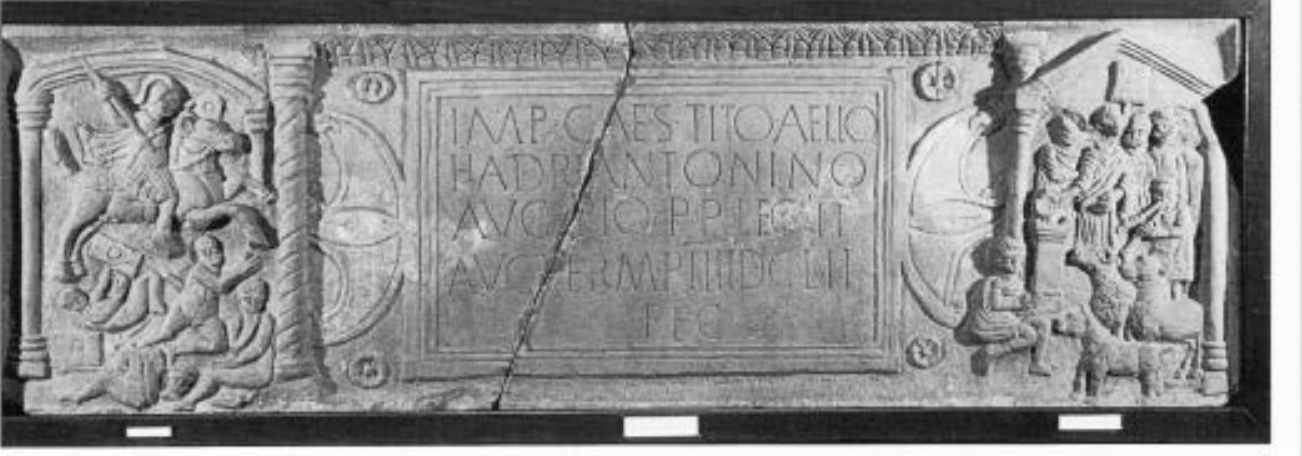
Figure 1 A monumental inscription flanked by reliefs showing Roman cavahy (left) and sacrifice (right) and recording the con­ struction in about AD 140 of part of the Antonine Wall on the frontier between the Forth and Clyde estuaries in Scotland. The text begins with the name and titles of the reigning emperor, Antoninus Pi us, and records that the Second Augustan Legion (LEG 11 AUG) constructed a stretch of the frontier 4652 paces in